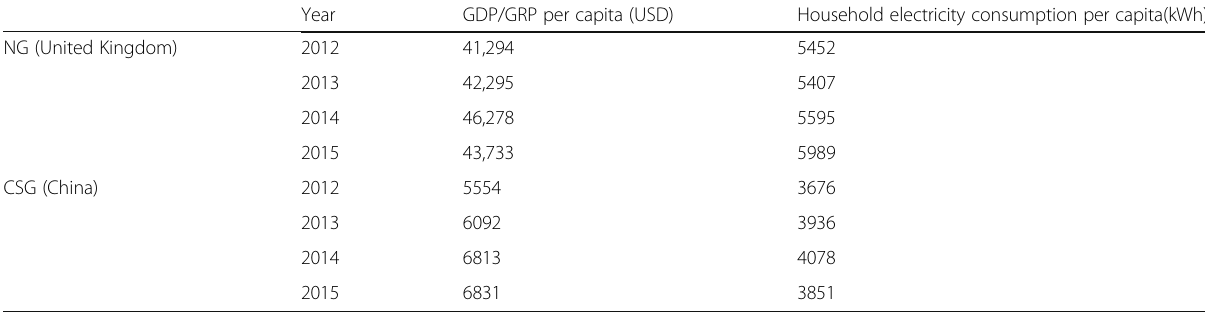
Table 1 GDP/GRP per capita and household electricity consumption per capita of CSG and NG Year GDP/GRP per capita